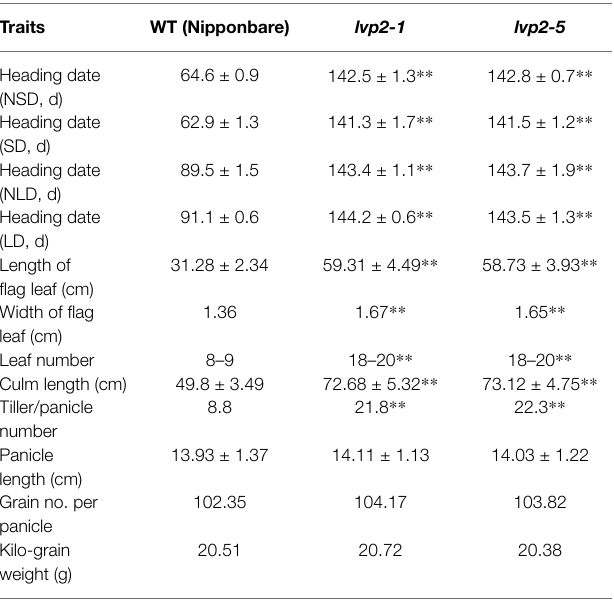
TABLE 1 | Main agronomic traits of WT, lvp2-1 , and lvp2-5